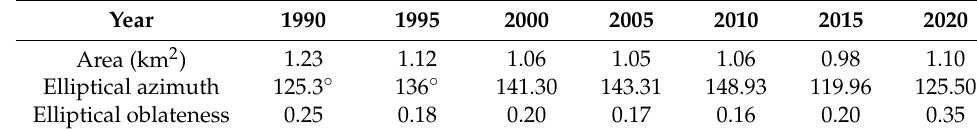
Table 3. Standard deviation ellipse parameters of different periods.